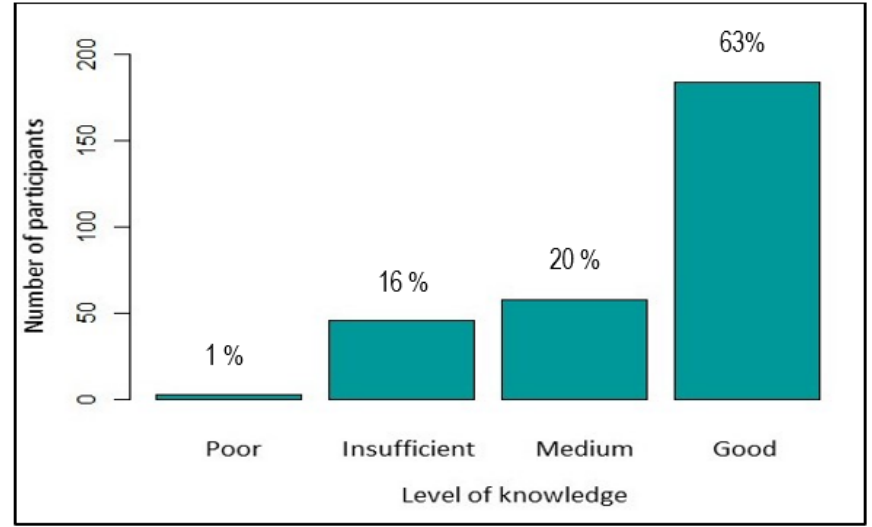
Figure 1. Level of knowledge about dengue.